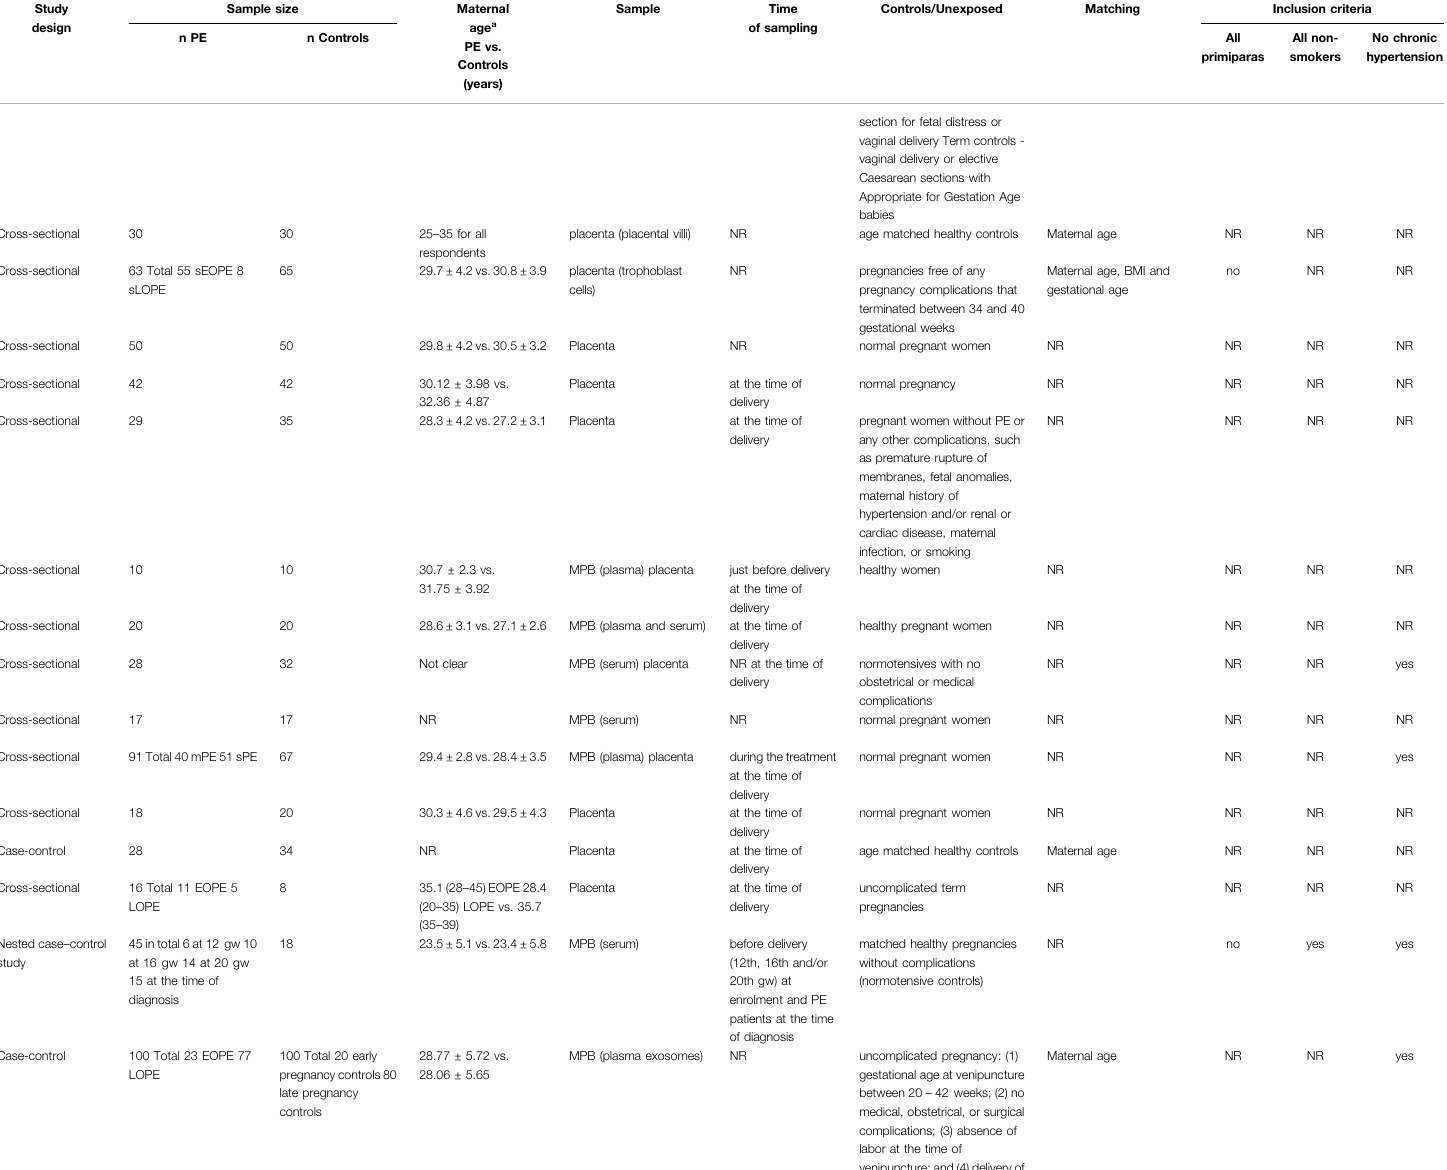
complications; (3) absence of labor at the time of venipuncture;and(4)deliveryof a normal term ( ≥ 37